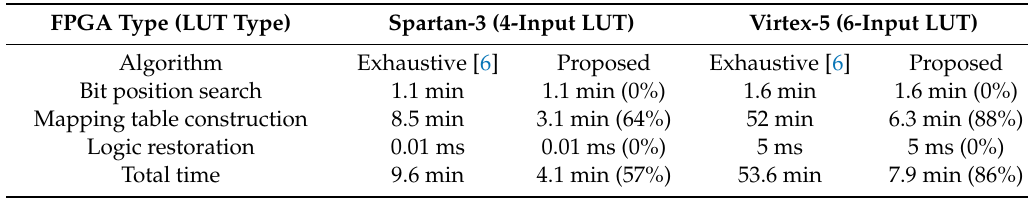
Table 1. Comparison of recovery time for a single LUT.